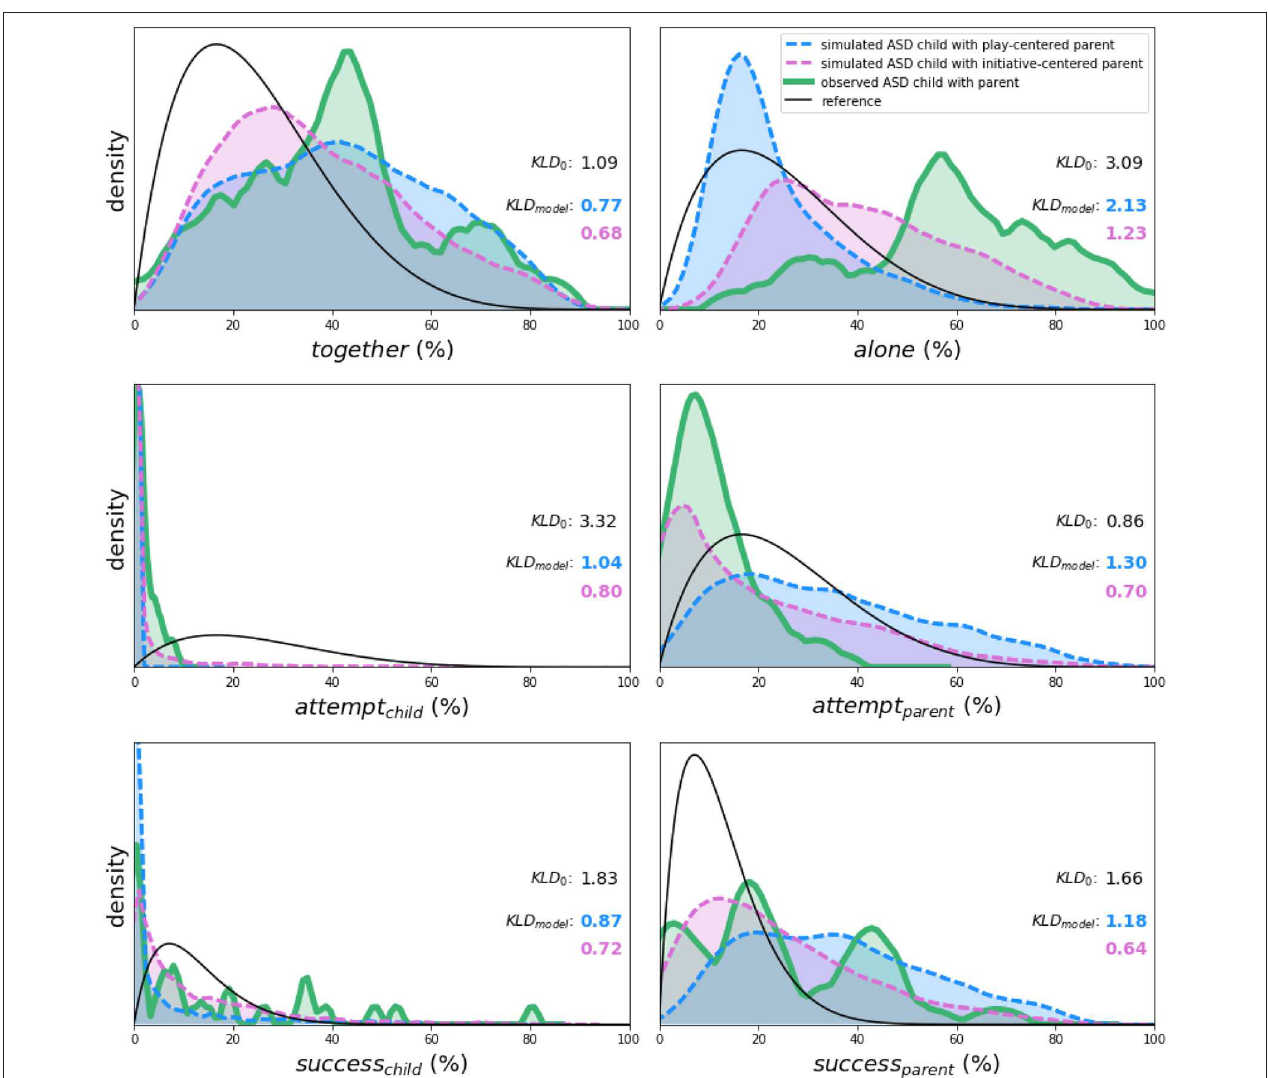
FIGURE 4 | Comparison of kernel density plots (similar to histograms) on all six variables between two simulated parent-child dyads (blue and pink dashed lines), one observed parent-child dyad (green solid lines) across play sessions in the context of ASD, and reference beta distributions (black line). Simulated distributions summarize 900,000 + time series data points generated by SECONDS – 225 time points over 2,000 sessions for each of the two dyads: a play-centered parent (blue) and an initiative-centered parent (pink). Observational distributions summarize over 26,000 time series data points gathered from one observed dyad (29 sessions; green). A qualitative, visual comparison of the distributions for simulated and observed dyads suggests surprisingly strong correspondences. We quantify the fit between each distribution and the observed dyad in terms of the Kullback-Leibler divergence ( KLD ; in information units of nats). The lower KLD , the better the fit. Most conveniently, KLD values are additive across variables, allowing us to estimate total model fit through summation. The simulated dyads have total KLD model of 7.28 and 4.76 nats for the play- and initiative-centered parents, respectively. Therefore, they outperform the reference distributions, which have a total KLD 0 of 11.83 nats , and the initiative-centered parent provides the best fit